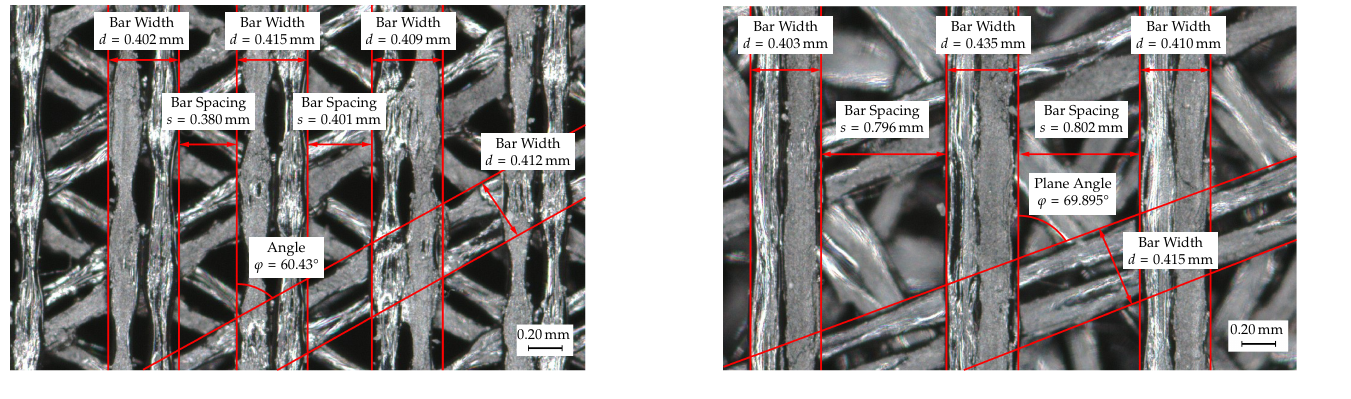
Figure 8. Actual-target comparison of specimens 2 and 39 using Keyence VR5200 3D surface profilometer. ( a ) shows specimen 2 with only slight deviations in the actual-target comparison. However, some small tapers can be seen in the filament strands. ( b ) shows specimen 39, which also shows only minimal deviations in the actual-target comparison.